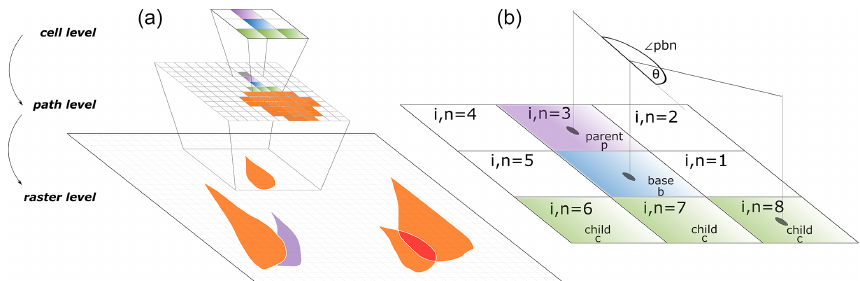
Figure 2. (a) The raster level summarizes the simulation results and output quantities for all GMF paths. The path level is the spatial level that contains the spatial extent of a path associated with one starting cell. (b) Iterative routing is done on the cell level. During an iteration the cells are defined as parent p , base b , child c , and all neighbor cells get two indices i and n . The angle θ is the deviation between the projected incoming and outgoing directions, with the angle (cid:54) pbn formed from the directions of parent p to base b and from base b to neighbor n